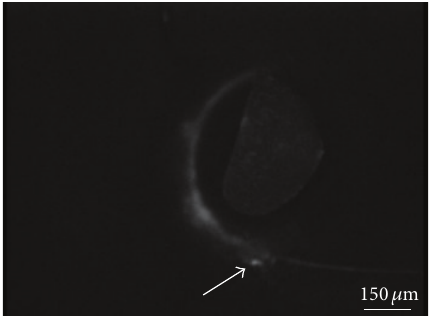
Figure 3: Filling of the collector channels ( ∗ ) observed in cor- respondence of the patent portions of Schlemm’s canal whose boundary was indicated by a circle. The bright H shape is due to the impregnation of the borders of the scleral flap due to partial reflux caused by the intrachannel resistance to dye